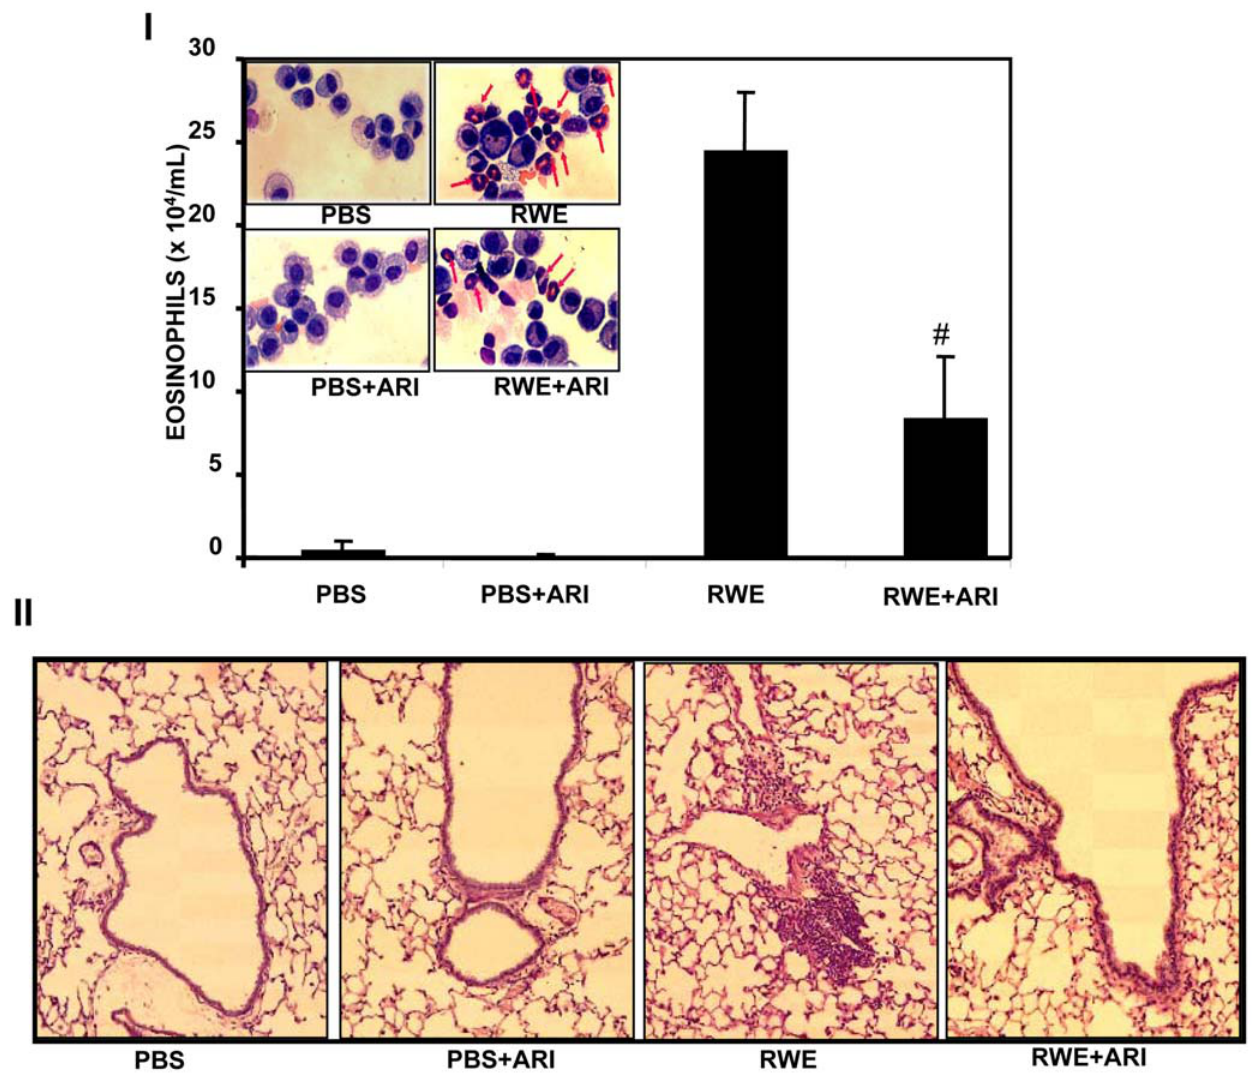
Figure 5. AR inhibition prevents RWE-induced accumulation of eosinophils in mice. ( I ) Determination of eosinophils in BAL. The Balb/c mice were sensitized and challenged with PBS, RWE, ARI alone, or ARI + RWE and 72 h later lungs were lavaged with ice-cold PBS and differential cell counts were performed on cytocentrifuge preparations stained with hematoxylin and eosin. Bars represent Mean 6 SD (n=6–8), # p , 0.002 Vs RWE. Inset : representative fields of hematoxylin and eosin preparations were photographed (magnification 6 90). ( II ) Determination of eosinophils in peribronchial and subepithelial regions of lung. Sensitized BALB/c mice were challenged as in (I), 72 h later lungs were excised, fixed with 4% paraformaldehyde, embedded in paraffin, and sectioned to 5 m m. Sections were stained with hematoxylin and eosin. Photomicrographs were acquired by photometrix CoolSNAP Fx camera mounted on a NIKON Eclipse TE 200 UV microscope. A representative field for each group is shown (magnification: 6 30). PBS, phosphate buffer saline; RWE, ragweed pollen extract; ARI, aldose reductase